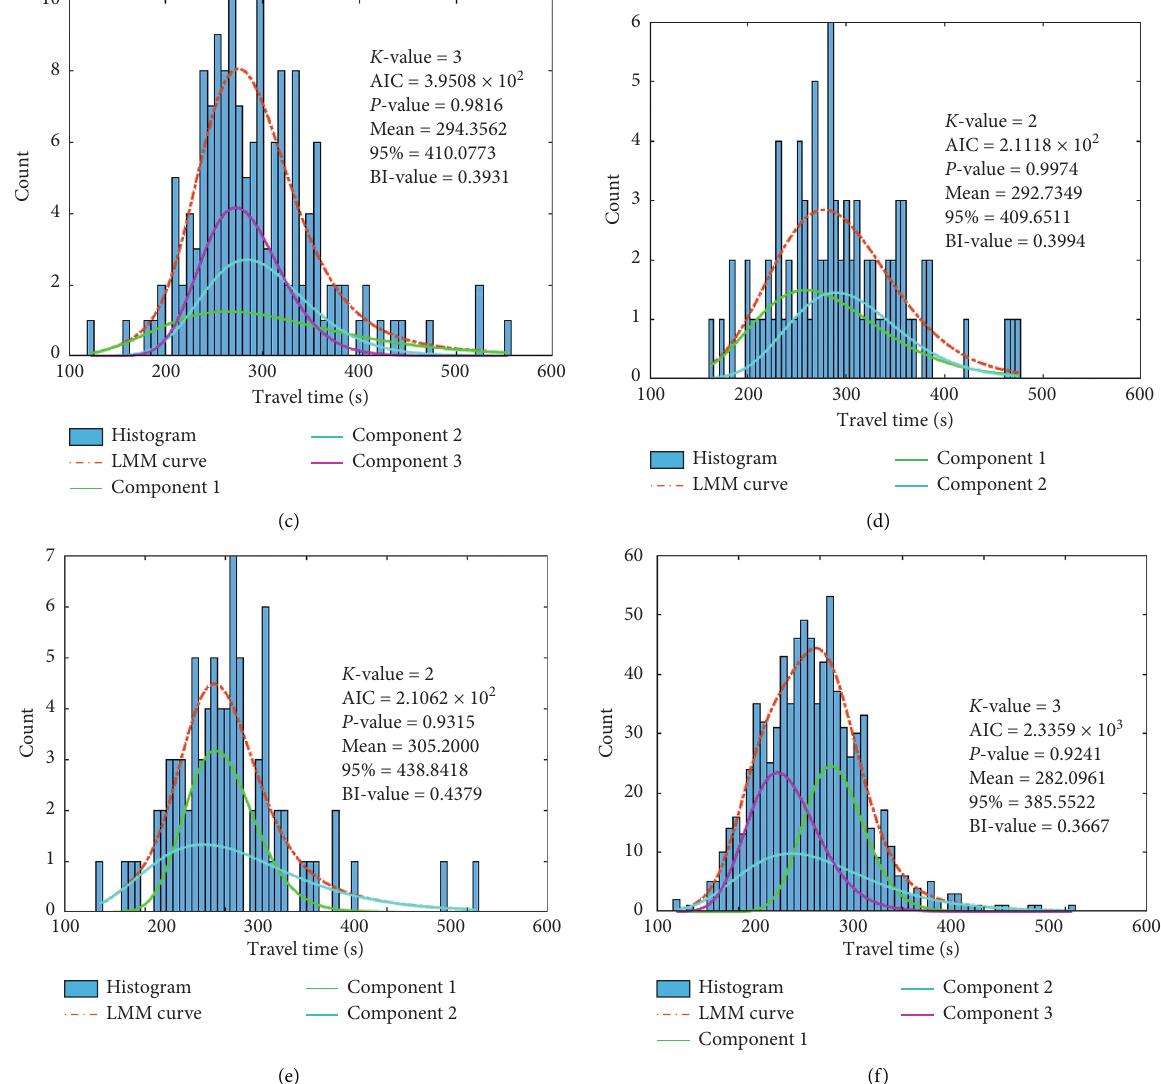
Figure 3: Fitting examples of LMM from Harrison Ave (ID:11) to Huntington Ave (ID:10): Part A: (a) normal and (b) light rain. Part B: (c) moderate rain and (d) heavy rain. Part C: (e) extreme rain and (f)